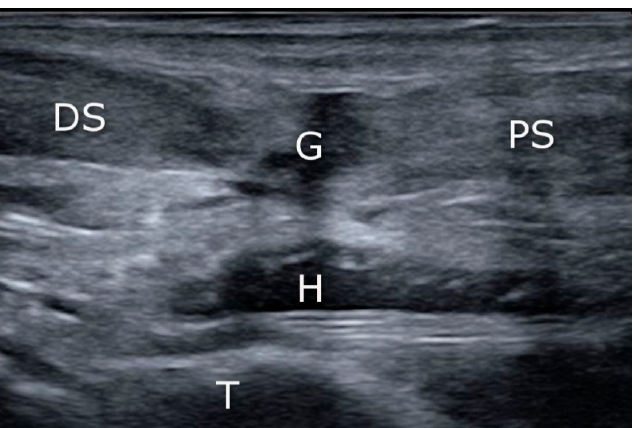
Figure 1. Achilles tendon tear: the sonographic appearance of acute Achilles tendon tear in the sagittal plane. G: gap (tendon lesion); H: hematoma; PS: proximal stump; DS: distal stump; T: tibia.